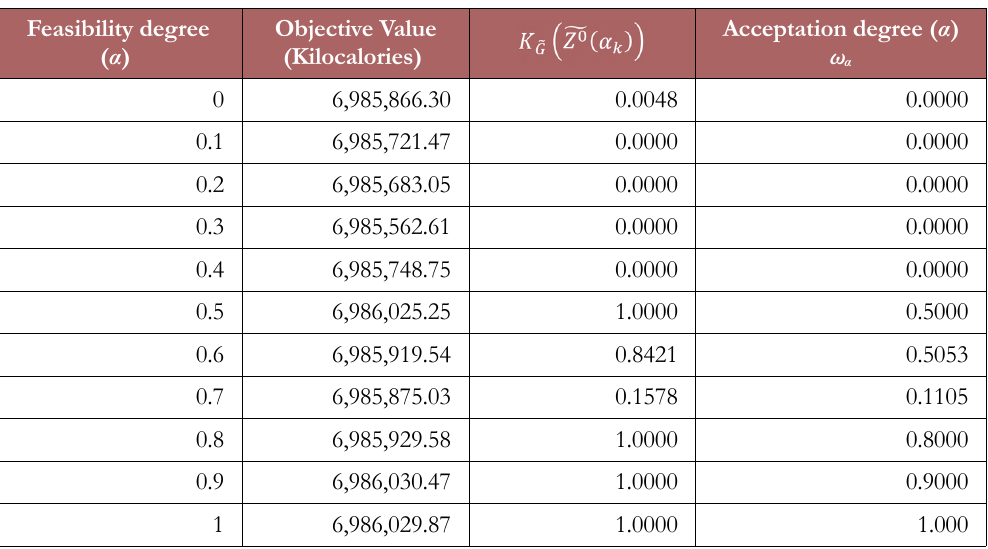
Table 3. Satisfaction degree of the DM in the fulfillment of objective value and